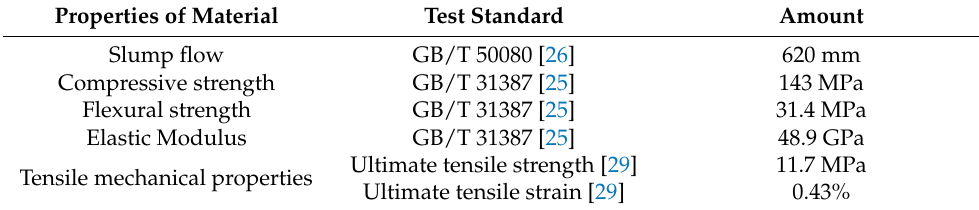
Table 4. Mechanical properties of strain hardening UHPC.